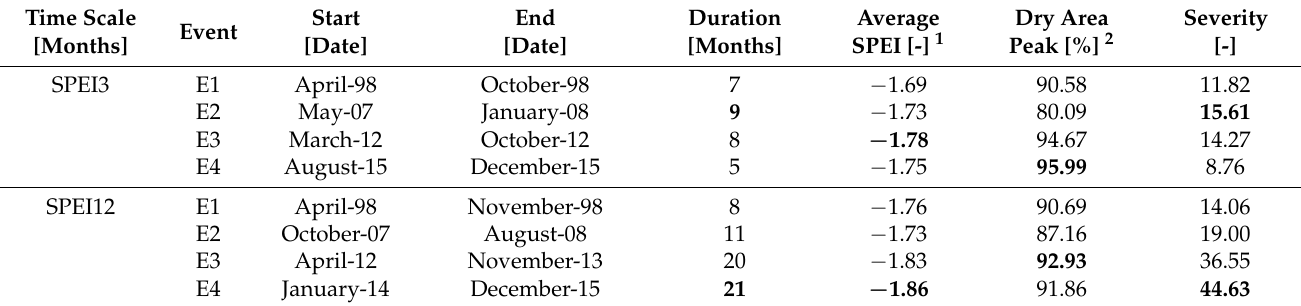
Table 3. Main features of the extreme drought events identified over the SFRB during